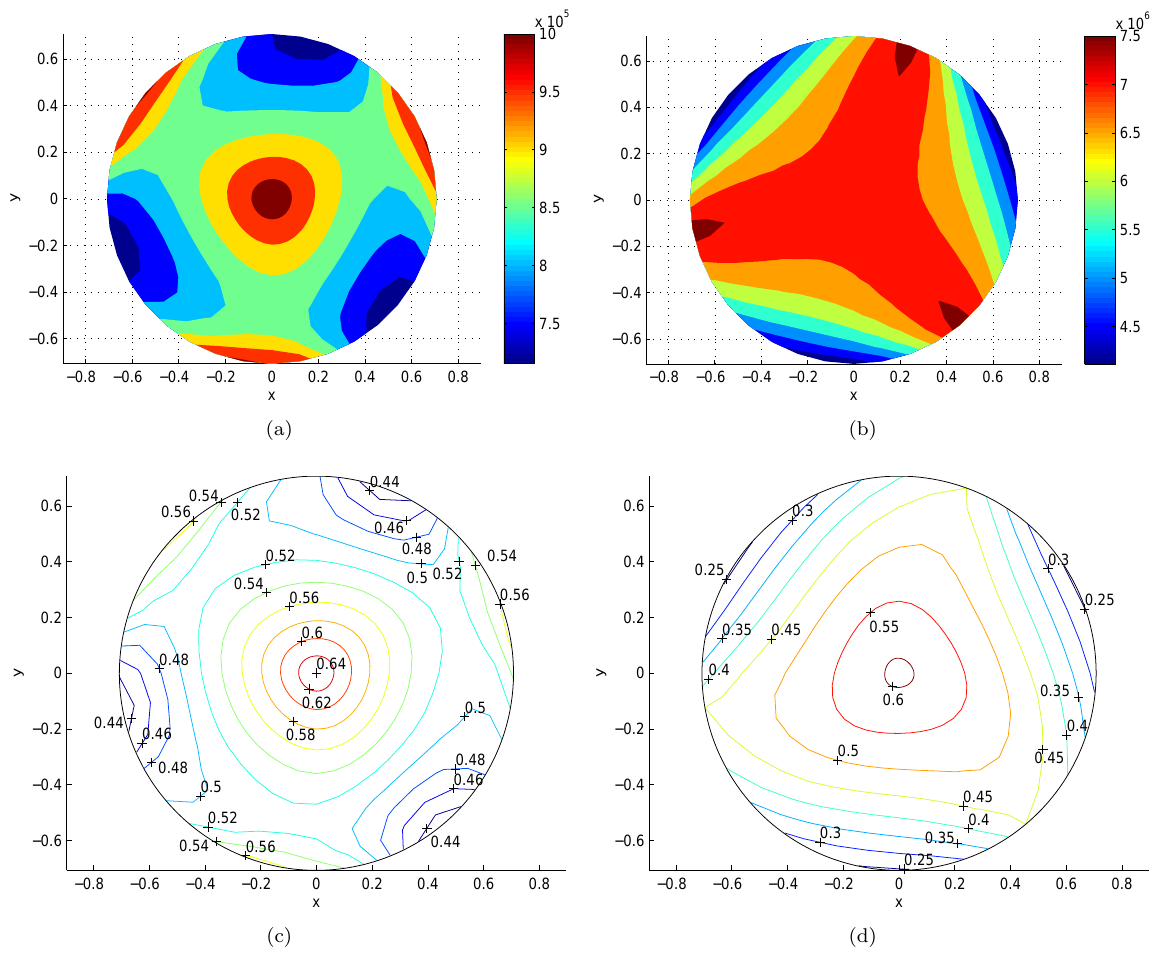
Figure 10: The distribution of the stiffness indices and isotropy over the regular workspace with torsion angle σ = 0: (a) κ r ; (b) κ t ; (c) ρ r ; (b) ρ t